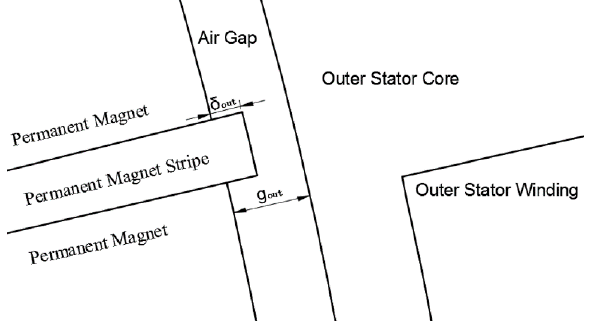
Figure 2. Partial view at A.